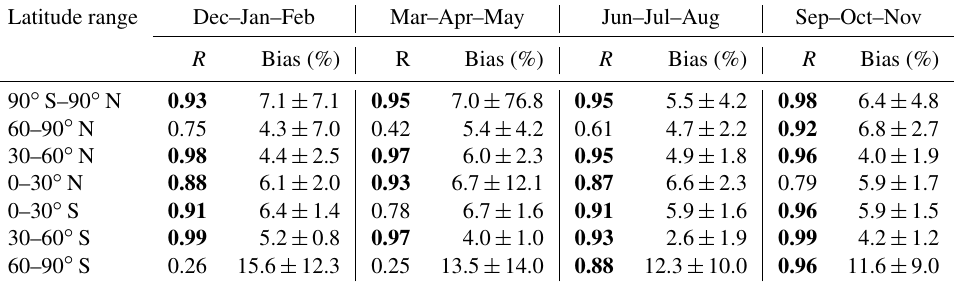
Figure 7. Time series of the monthly relative differences (in percent) between IASI-A (blue) and IASI-B (red) against GOME-2A O3M SAF total ozone columns for different latitudinal bands. The associated standard deviation is also displayed. Table 2. Summary of the correlation ( R ), the bias, and the standard deviation of IASI-A total ozone column retrieved from FORLI-O3 v20140922 relative to the O3M SAF GOME-2A retrievals, for each season of the period 2008–2014. The bias and the standard deviation are given in percent. The correlation coefficients higher than 0.85 are indicated in